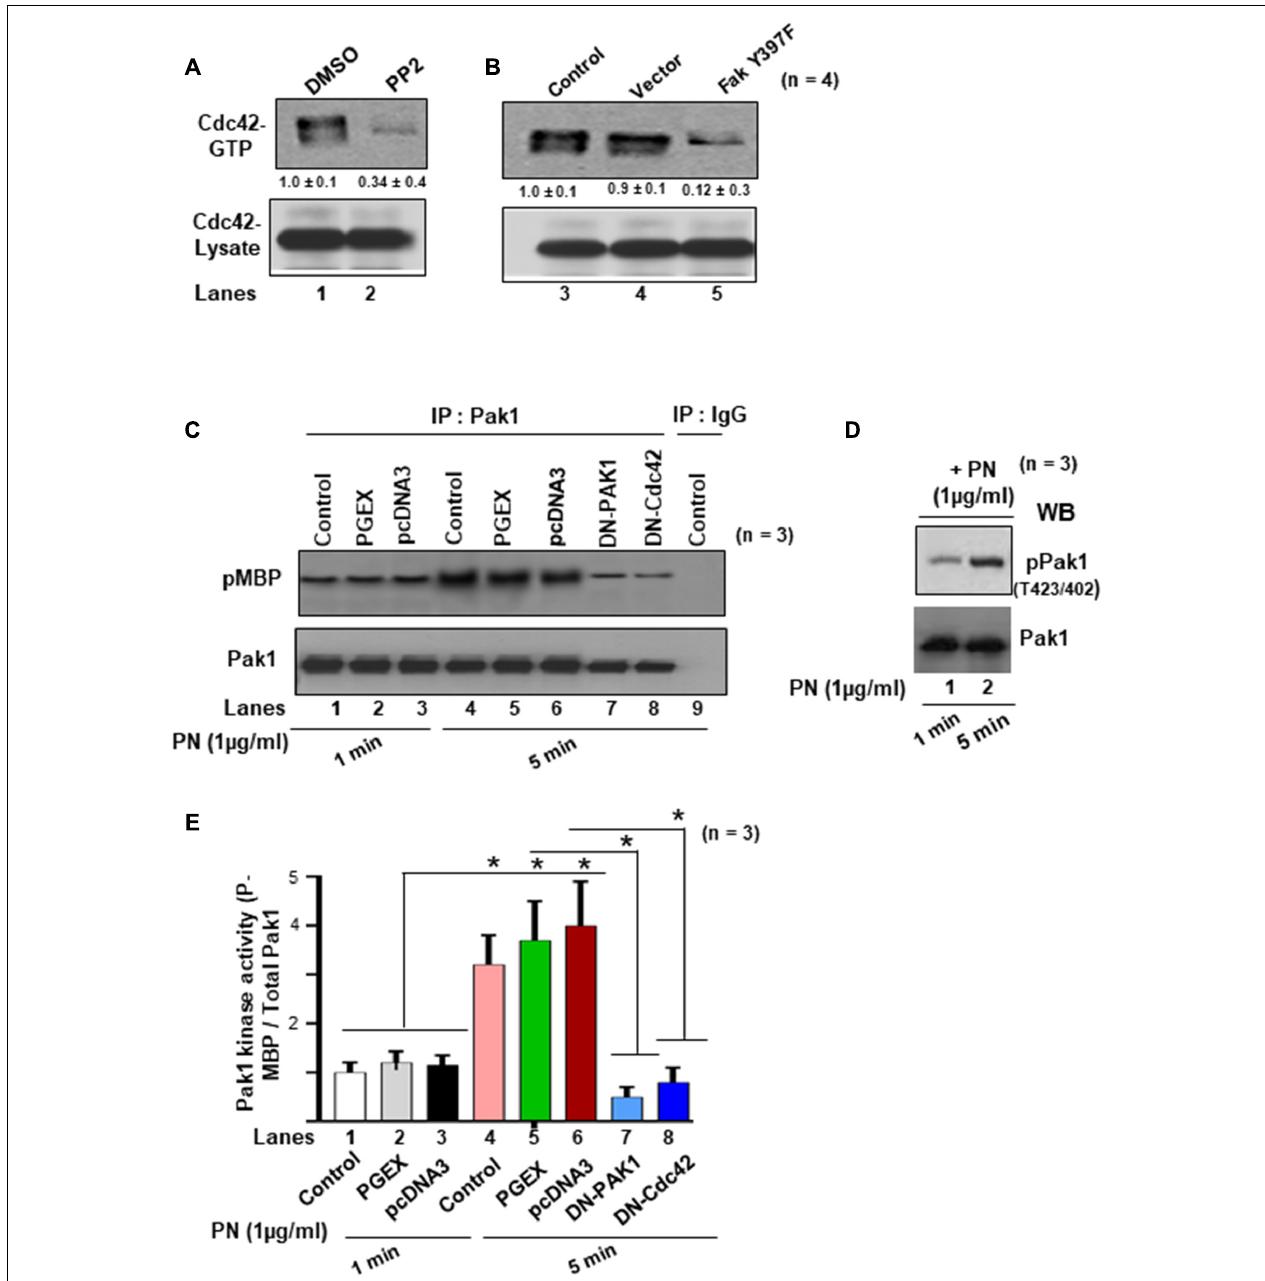
FIGURE 3 | Activations of Cdc42 and Rac1 are associated with PN, which induced both the autophosphorylation and the kinase activity of Pak1 in the VIC ex vivo cultures. (A) Serum-deprived cells were cultured in the presence of either DMSO or Src inhibitor PP2 (5 µ M). Pull-down assays for active Cdc42 were done using GTP-loaded PAK-1-binding domain (PBD)-GST beads. (B) Cells were either uninfected (control), or infected with lentivirus-expressing vector, or Fak (Y397F) and analyzed for active Cdc42 as in Figure 2B . (C) VICs were either transfected with DN Pak1 or DN Cdc42 constructs for 48 h. Cells were treated with 1 µ g/ml PN for 1 or 5 min at 37 ◦ C, and a nonradioactive kinase assay was done using the traditional in-gel phosphorylation assay. For details of this experiment see the “Materials and Methods” section. Pak1 kinase activity was evaluated by phosphorylation of substrate MBP (pMBP). The amount of immunoprecipitated PAK was controlled by anti-PAK1 immunoblotting. Isotype control IgG was used as experiment control. (D) Autophosphorylation of PAK (pPAK) was measured after 1- and 5-min treatments with PN [substrate 1 µ g of myelin basic protein (MBP)] and was visualized as a 65-kDa phosphoprotein and detected by direct immunoblotting with anti-phospho PAK1/2 Thr423/Thr402. Results are representative of two separate experiments. (E) PAK activation was evaluated as in vitro kinase activity toward MBP. Quantification of PAK activity from the experiment of (C) was done by densitometry analysis on ratio of expression of pMBP and total Pak1. In panel (A) , the values were determined by densitometry, and the values derived from control cells (either NT shRNA or untreated cells) were designated as 1.0. Results reported in bar graphs in panel (E) are presented as means ± SD of ≥ 3 separate experiments (* p ≤ 0.05). Western blot data are representative of ≥ 3 independent experiments.